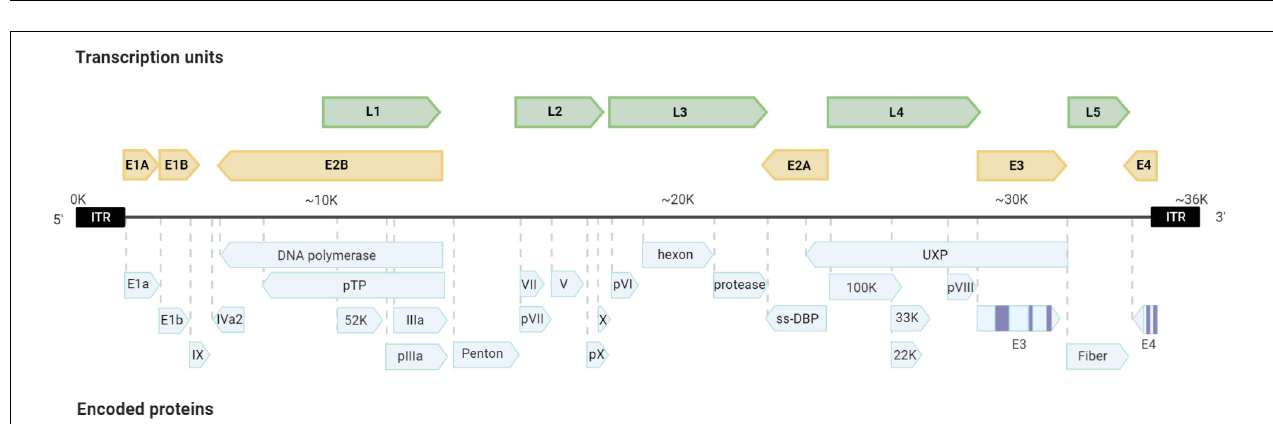
FIGURE 1 | Overview of the Adenovirus replication cycle. Early and late phases of the cycle are indicated. The viral DNA replication marks the progression from early to late transition.